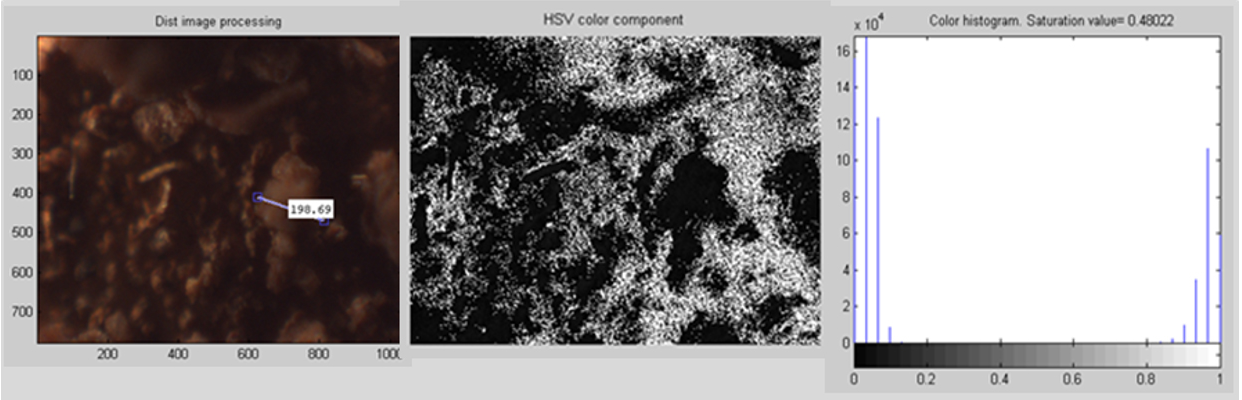
Figure 3. Image of a Luvisol sample, 0 cm height, and pre-processing.